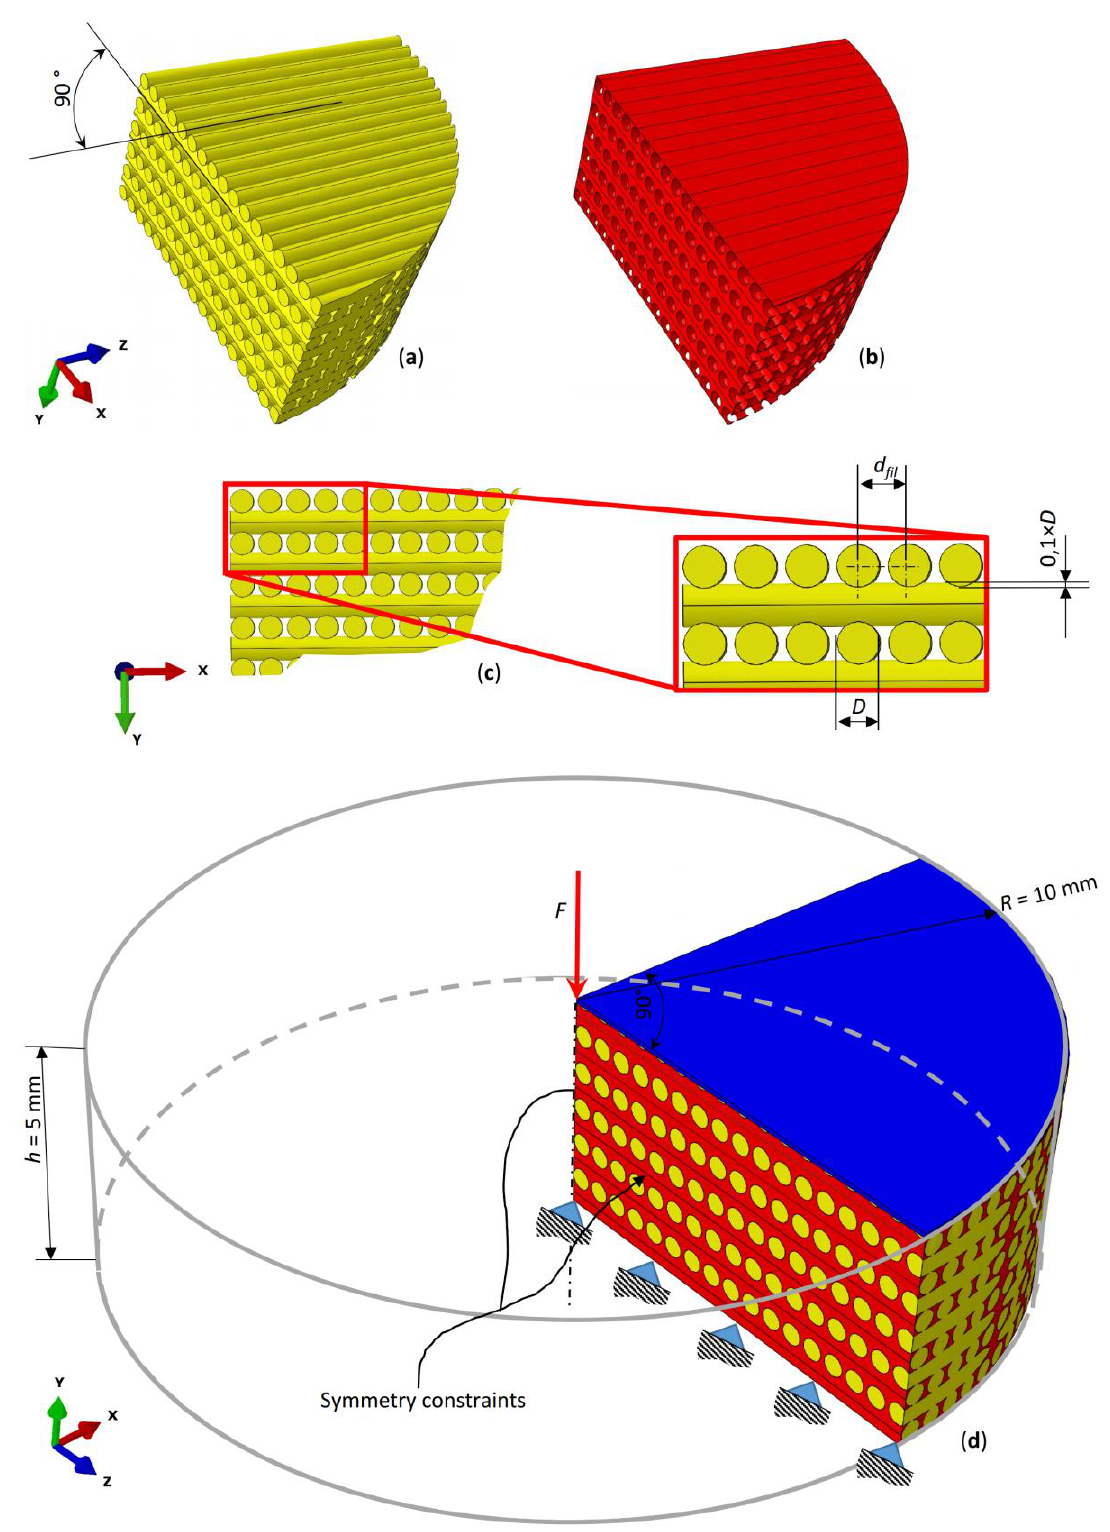
Figure 1. Parametric model of the scaffold ( a, c ) and of the granulation tissue ( b ) occupying the scaffold pores. ( d ) Exploiting the symmetry of the system, the one-quarter model was investigated.